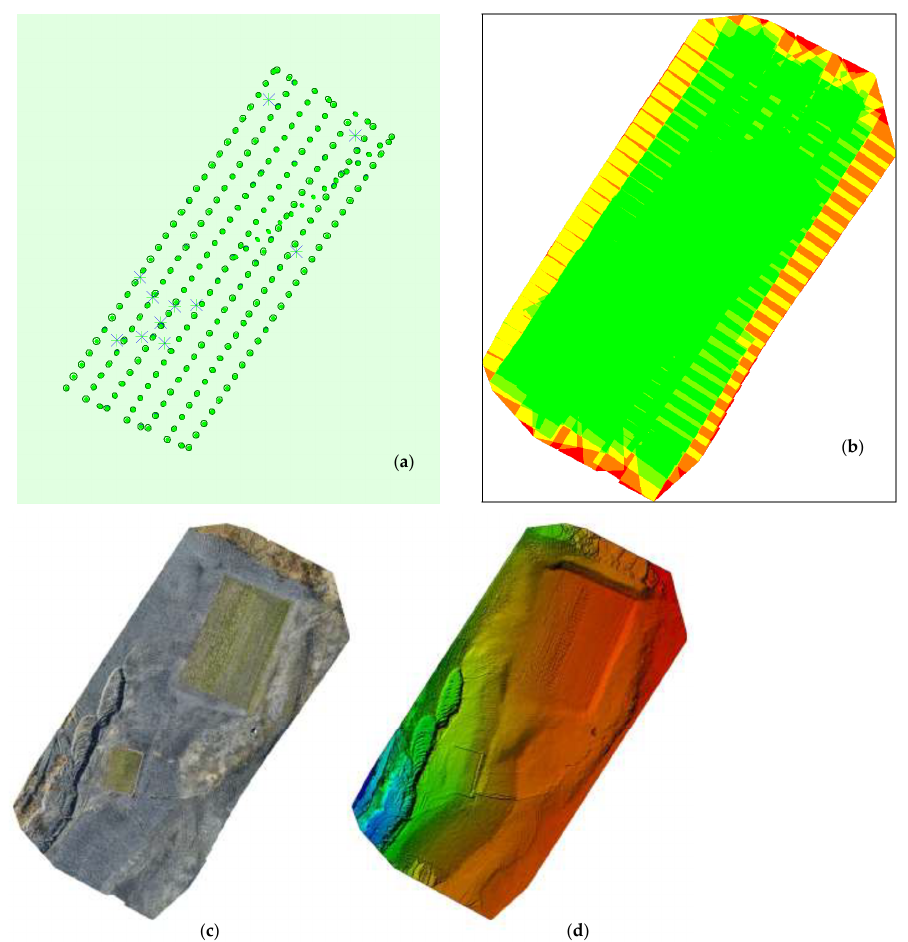
Figure 12. An example of photo processing: ( a ) Initial Image Positions, ( b ) Overlap between images ( c ) Orthophoto map, ( d ) Numerical model of studied area coverage (19 April 2022).